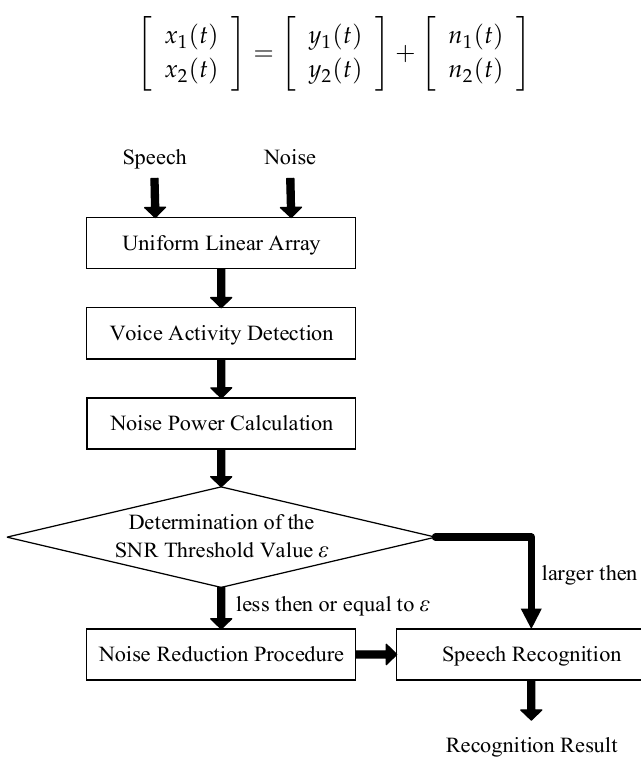
Figure 2. Procedure of proposed threshold-based noise detection.